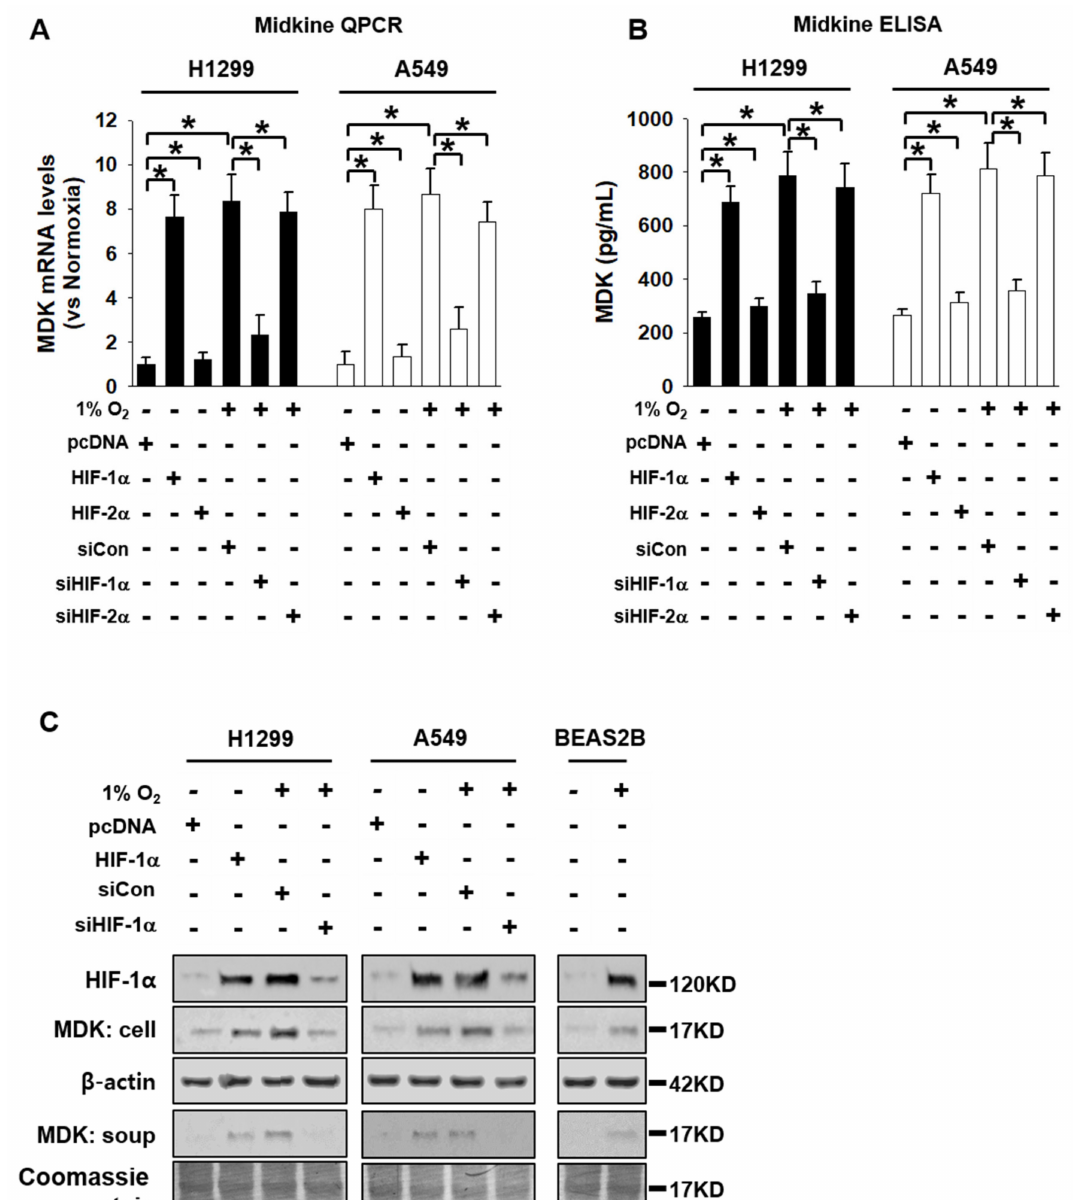
Figure 2. MDK levels were increased by HIF-1 α in NSCLC cells. ( A ) MDK mRNA levels were increased by HIF-1 α . H1299 and A549 cells were transfected with pcDNA, HIF-1 α , HIF-2 α , siCon, siHIF-1 α , and siHIF-2 α under normoxic and hypoxic conditions; then, MDK mRNA levels were measured by quantitative RT-qPCR. ( B ) and ( C ) Under the same conditions as in Figure 2A, MDK protein levels were analyzed using MDK ELISA assay and immunoblotting. Student’s t -test was performed and values displayed as average ± SD; n = 6, * p < 0.05. These cells and CM were harvested with lysis bu ff er and western blotting was